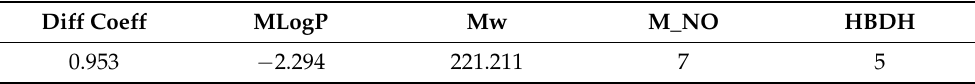
Table 3. Drug ability of 2-acetamido-2-deoxy-hexopyranose. Diff coeff MLogP Mw M_NO HBDH 0.953 221.211